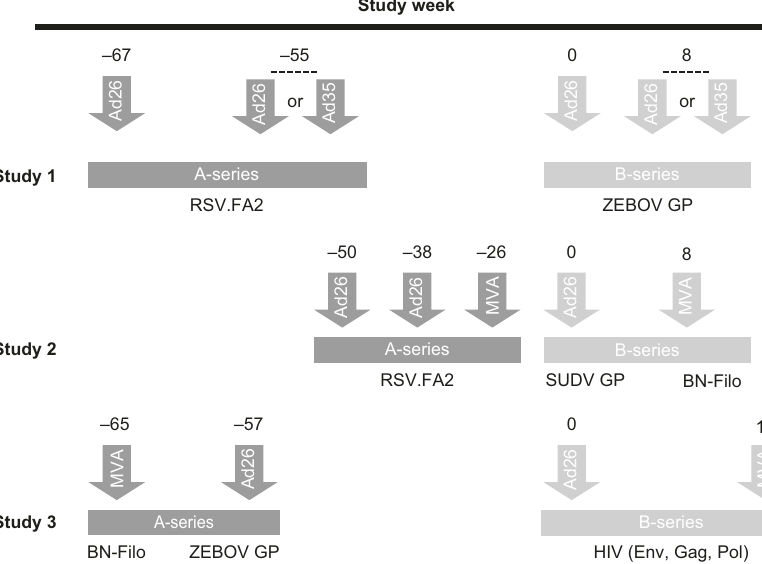
Fig. 1 Summary of study designs and immunization regimens. Generic study NHP designs: Ad26 vaccines administered during A-series as a homologous or heterologous regimen with Ad35 or MVA was followed 26 to 57 weeks later by B-series of the same vector-backbone regimen. In all studies, the vaccines given during A- and B-series administration encoded different antigens. Study 1: Animals pre-exposed to Ad26 or Ad35 encoding a RSV.FA2 antigen were dosed 55 weeks after the last vaccination (A-series) with the same sequence of Ad26- or Ad35- encoding EBOV GP in B-series (dose 1, week 0; dose 2, week 8). Control animals received the same EBOV GP – encoding homologous or heterologous regimens at week 0 and week 8 in B-series. Study 2: Animals pre-exposed to Ad26 and MVA encoding a RSV.FA2 antigen were dosed 26 weeks after the last vaccination (A-series) with the same sequence of Ad26 or MVA, with Ad26-encoding SUDV GP (dose 1, week 0) and MVA-BN-Filo (dose 2, week 8), respectively, during the B-series. Control animals received the same SUDV GP – encoding vaccines at week 0 and week 8 in B-series. Study 3: Animals pre-exposed to MVA-BN-Filo and Ad26-encoding EBOV GP were dosed 57 weeks after the last vaccination (A-series) with the same sequence of Ad26 or MVA encoding a mosaic of HIV Env, Gag, and Pol antigens (dose 1, week 0; dose 2, week 12) in B-series. Control animals received the same vaccine (Ad26 then MVA) at week 0 and week 12 in B-series. Details of the study designs are provided in Supplementary Fig.